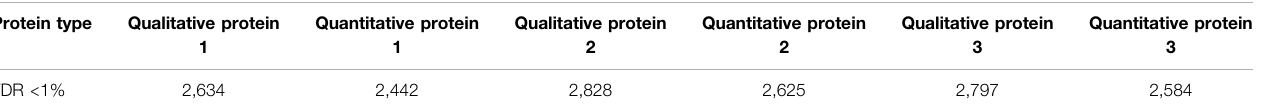
TABLE 2 | The reliable numbers of the proteins identi fi